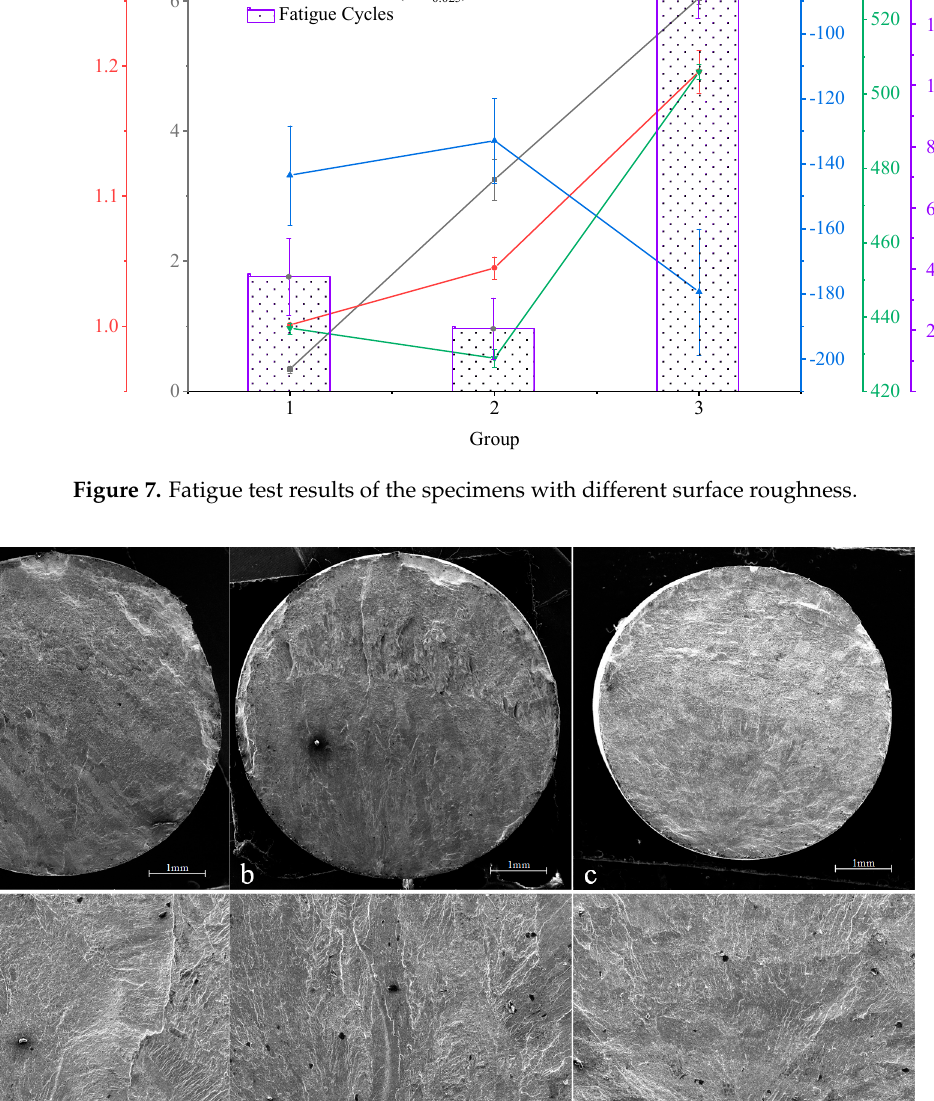
Figure 7. Fatigue test results of the specimens with different surface roughness.